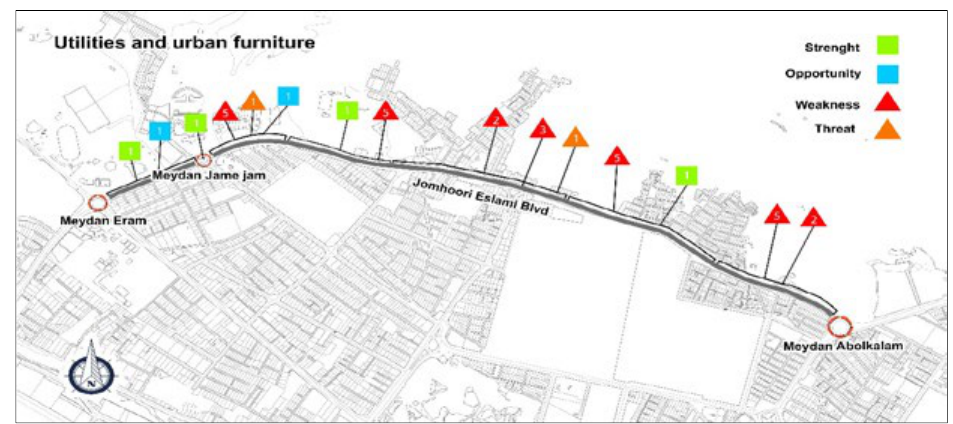
Fig. 8. Utilities and urban